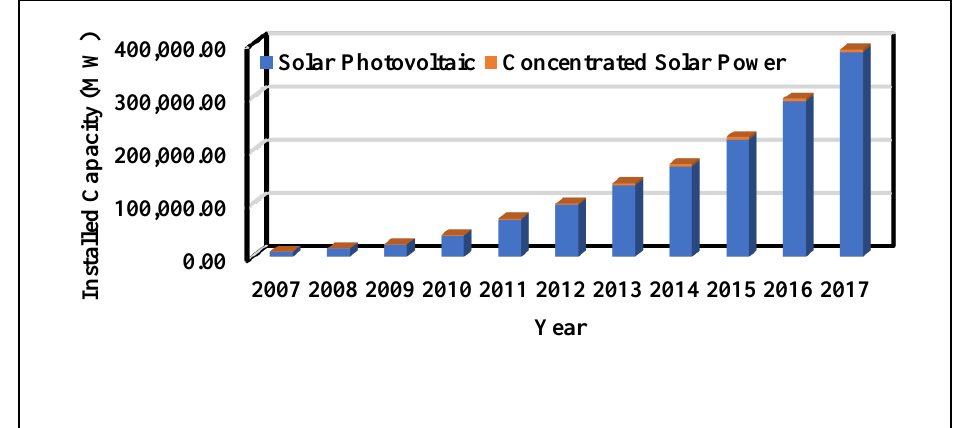
Figure 11. Renewable energy trends in the UAE (installed capacity in MW) [65].